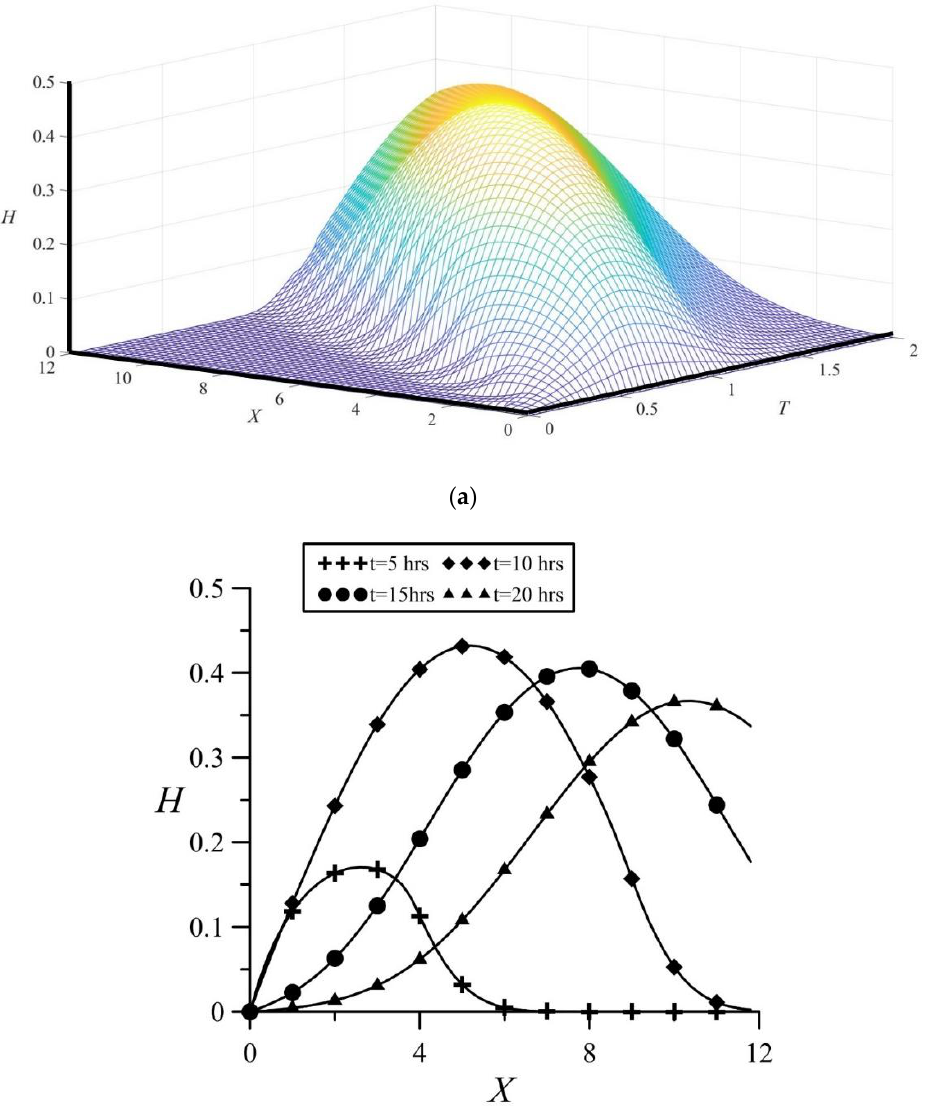
Figure 6. The effect of a unimodal rainfall with hourly data (10, 20, 30, 40, 50, 60, 50, 40, 30, 20, 10 mm/hr) on the groundwater level with parameters α = 19.6078, U = 10.3722. ( a ) spatiotemporally distributed variation of groundwater level, and ( b ) variation of groundwater level in space at some specific moments.